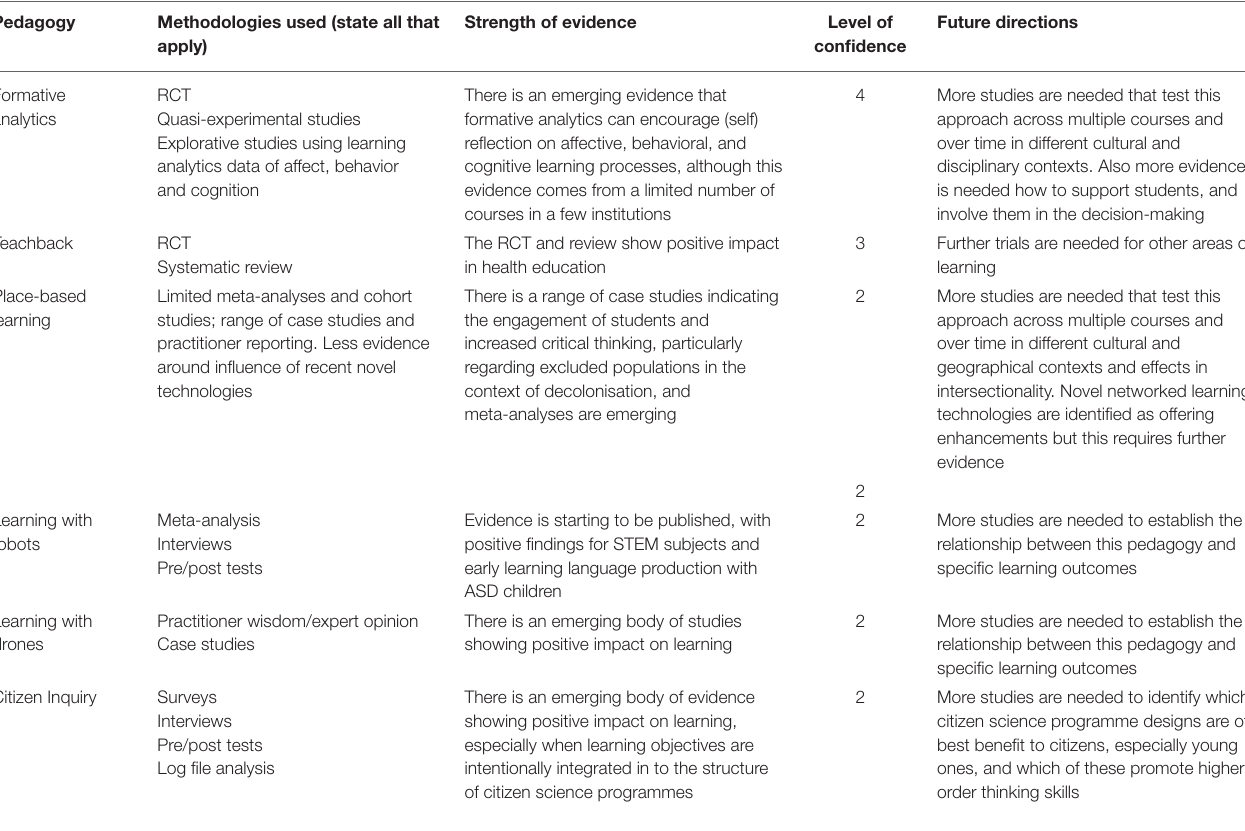
TABLE 1 | Future directions of selected pedagogies.